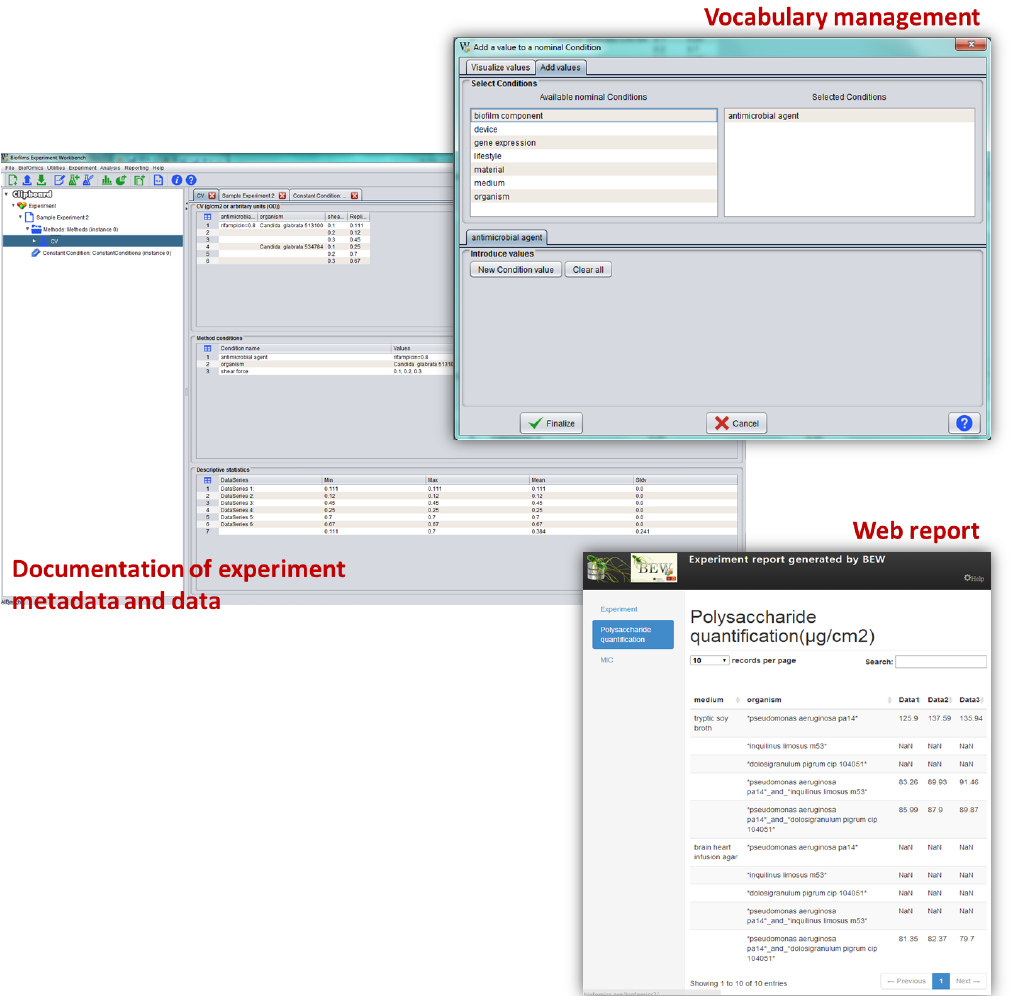
Figure 6: Example of an experiment report generated by the Biofilms Experiment Workbench and supported by the Biofilms